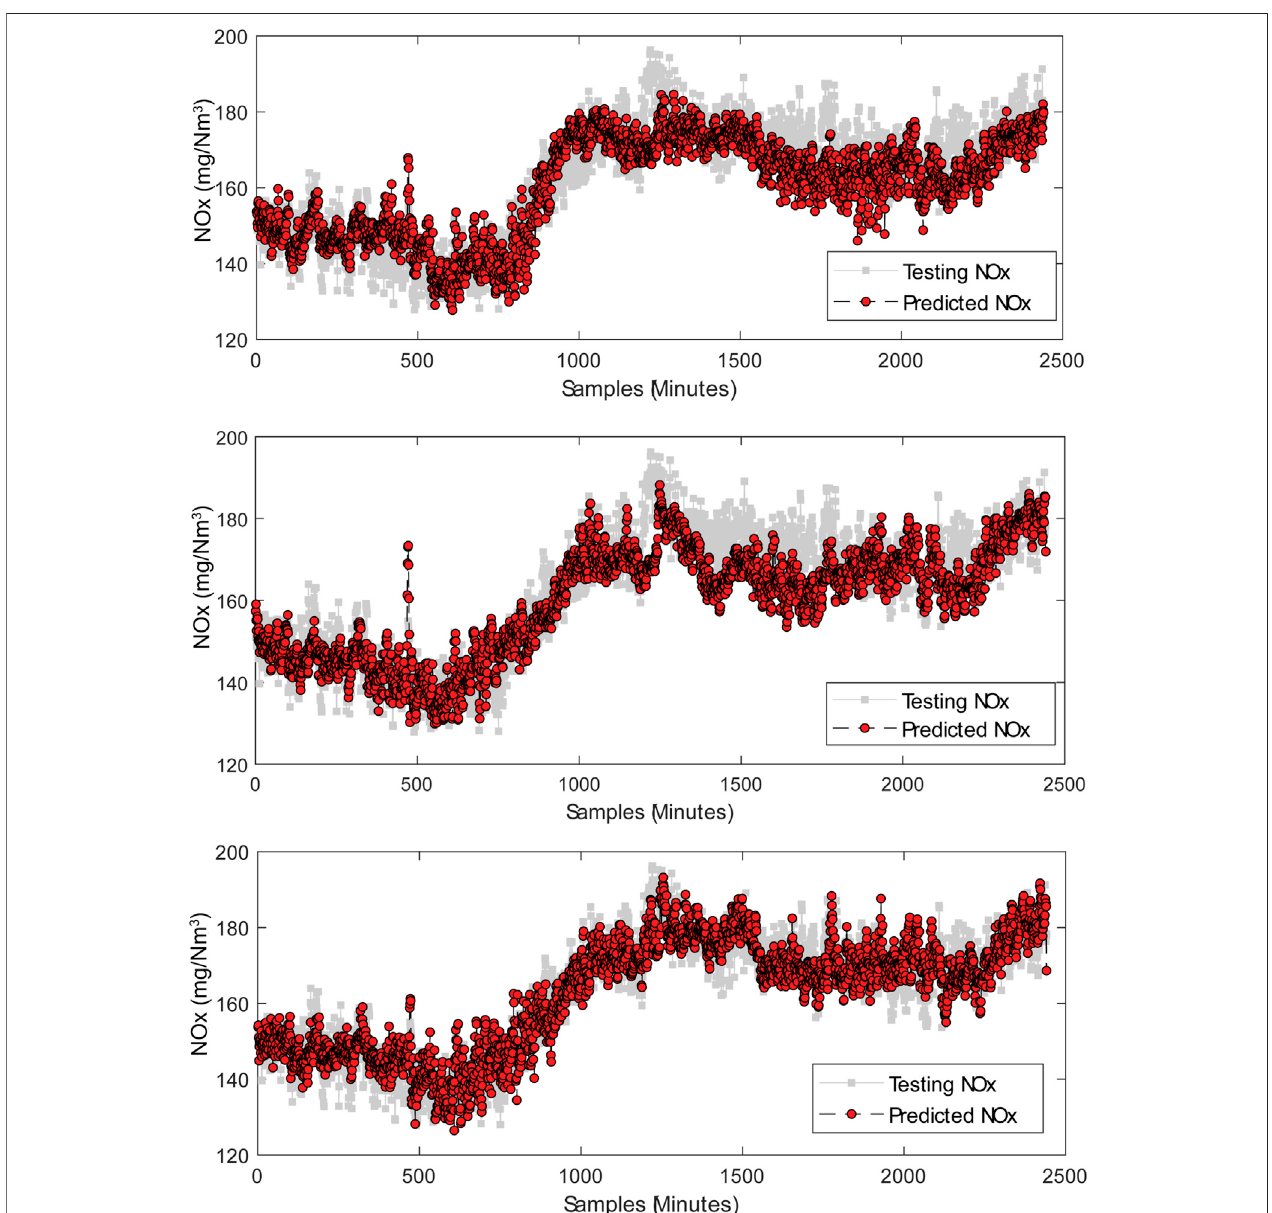
FIGURE 9 | (A) LSTM testing data NOx prediction. (B) GRU testing data NOx prediction. (C) 1D-CNN testing data NOx prediction.